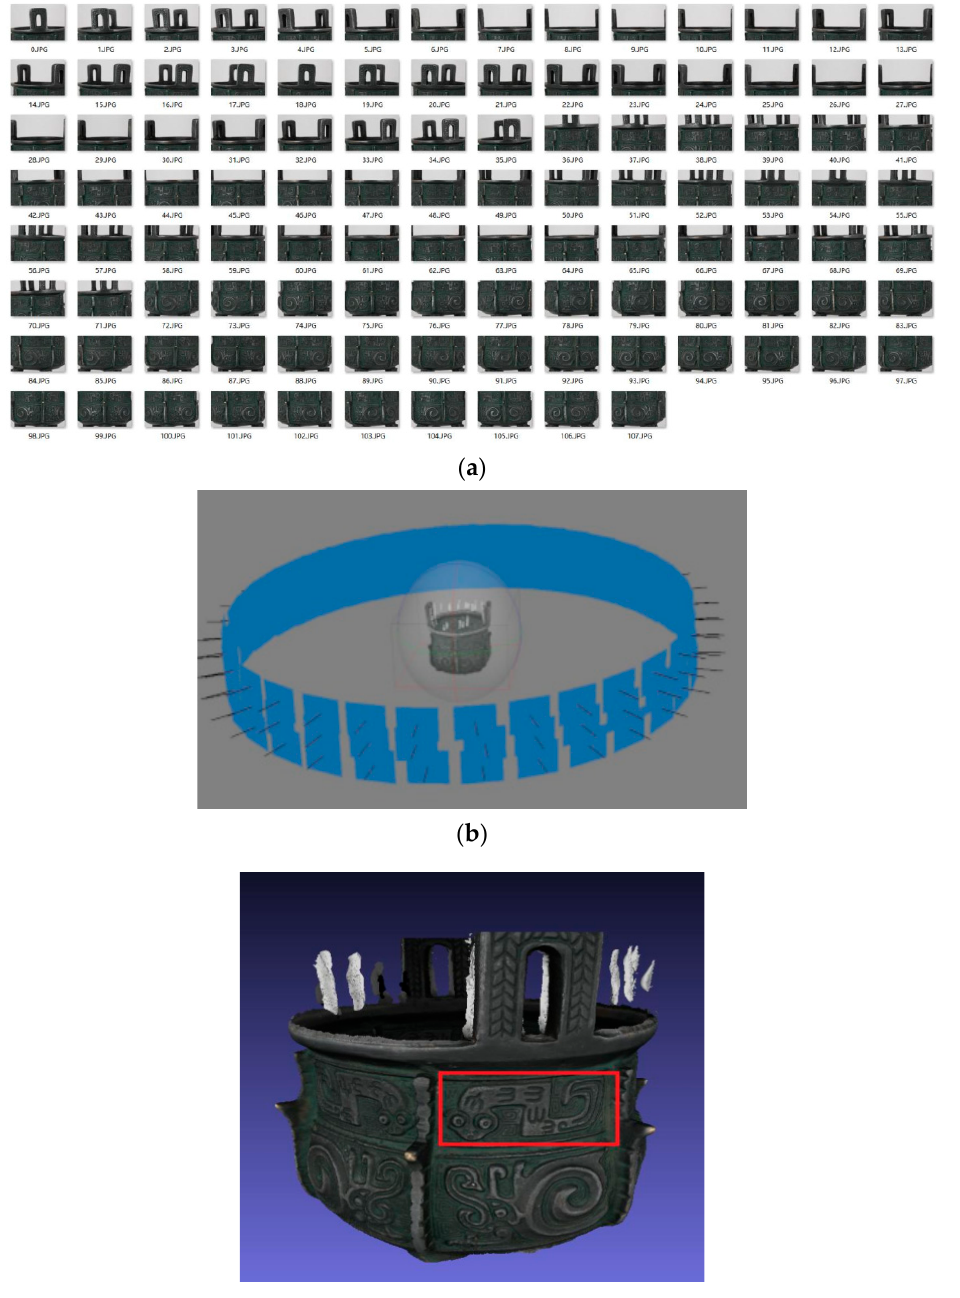
Figure 6. Multi-view image set and reconstructed 3D model. ( a ) Multi-view image set; ( b ) shooting angle of images; ( c ) reconstructed 3D model